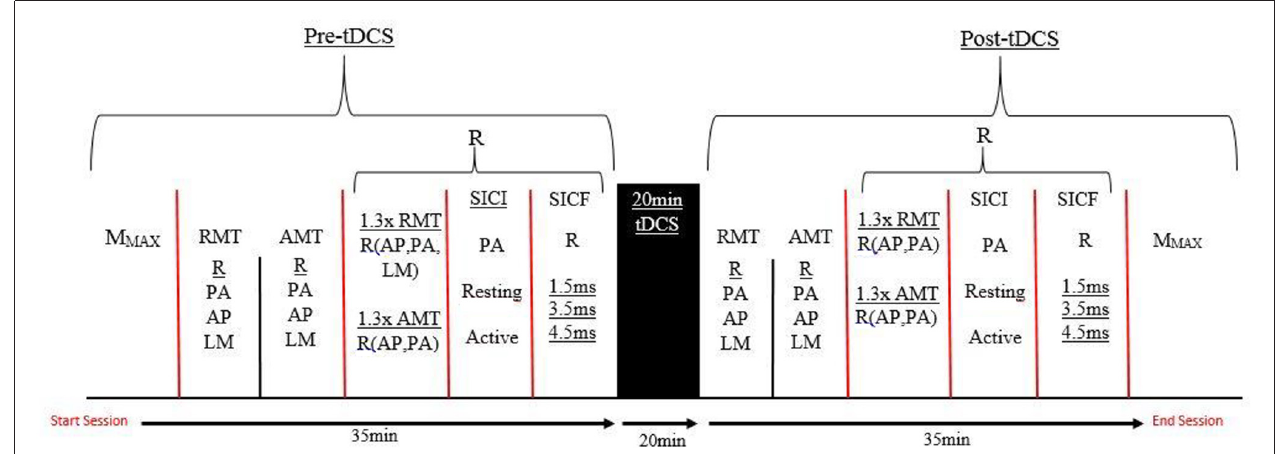
FIGURE 1 | A timeline of the testing protocol in both testing sessions. R, Randomized order; AMT, Active motor threshold; RMT, Resting motor threshold; PA, Posterior-anterior; AP, Anterior-posterior; LM, Latero-medial; SICI, Short interval intracortical inhibiton; SICF, Short interval intracortical facilitation; tDCS, transcranial direct current stimulation; M MAX , Maximal muscle